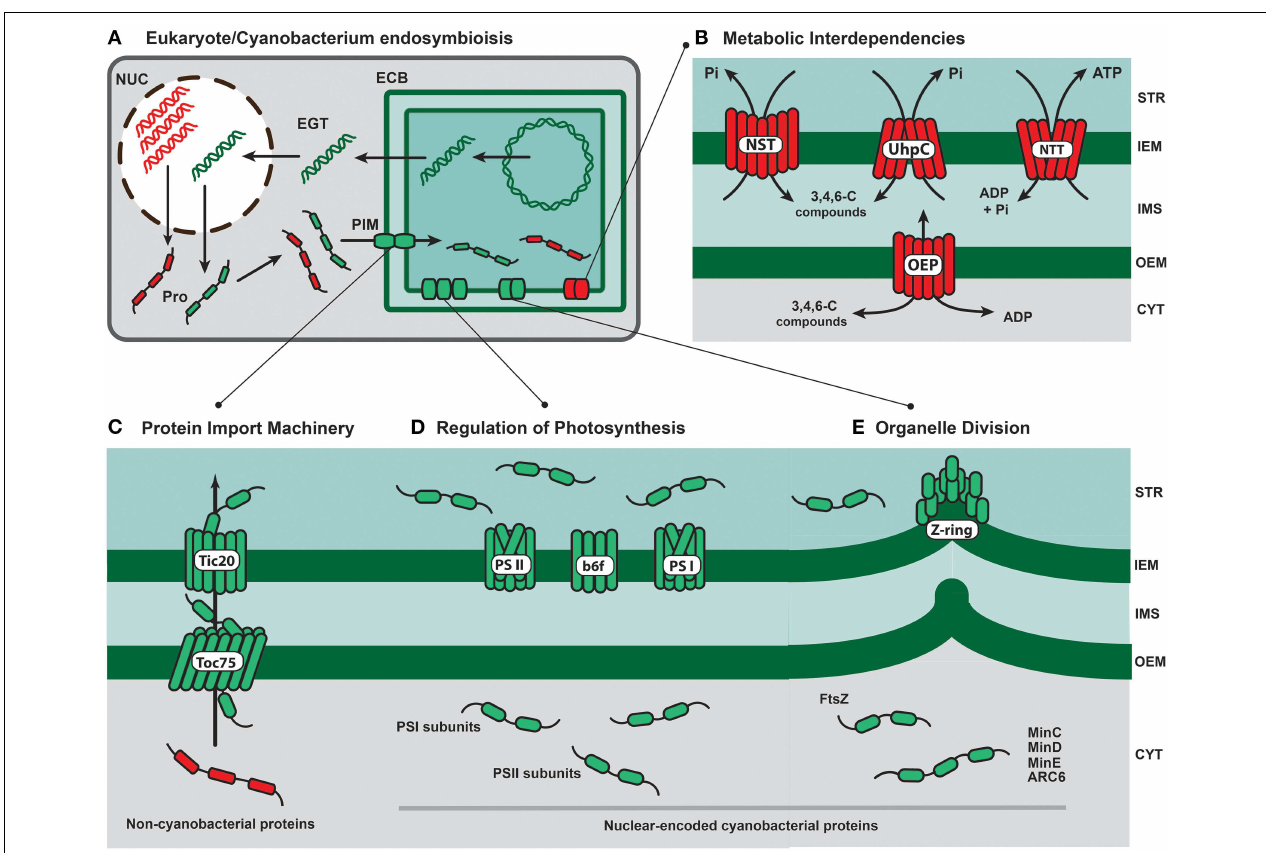
FIGURE 1 | Key subcellular events and proteins involved in the evolution of primary photosynthetic organelles. (A) The genome reduction of the endosymbiotic cyanobacteria (ECB) was triggered by both gene losses via deleterious events and endosymbiotic gene transfer (EGT) into the host nucleus (NUC). Successfully transferred genes (green double strands) should have been expressed and translated in the host nucleocytoplasm system. Cytoplasm-translated proteins (Pro) of non-cyanobacterial origin (red ribbons) and cyanobacterial provenance (green ribbons) were imported into the cyanobacterial compartment via the ancestral protein import machinery (PIM). (B) The recruitment of cytoplasm-translated membrane transporters of host (e.g., members of the NST family and hexose transporters of the UhpC type) and diverse bacterial (e.g., the Chlamydiae-like ATP/ADP nucleotide translocator; NTT) sources was essential for the establishment of steady metabolite (e.g., 3-, 4-, or 6-carbon compounds; ATP) fluxes and further evolution of metabolic interdependencies. OEP represents diverse host-derived pore proteins (e.g., OEP24, OEP16 and OEP21) that facilitate the transport of a broad range of metabolites across the outer envelope membrane. (C) The evolution of the core plastid protein import system relied on the activity of the cyanobacterial proteins Toc75 and Tic20. These two pore-forming proteins were present originally in the plastid ancestor genome but the encoding genes were likely transferred early during endosymbiosis to the host genome (Tic20 are still plastid-encoded in some algal lineages). The ancestral organelle import system was able to translocate both cyanobacterial (green ribbons) and non-cyanobacterial (red ribbons) proteins translated in the host cytoplasm. (D) Other transferred cyanobacterial genes with putative key roles on plastid evolution were those encoding subunits of the Photosytems I ( psa E, psa I, psa K) and II ( psb O, psb P, and psb U) with important roles for the photosynthetic activity under stress conditions. The cytochrome b 6 f complex (b6f) is indicated. (E) Initial host control over the endosymbiont division likely relied on transferred cyanobacterial genes encoding cytokinesis-associated proteins, such as FtsZ, which is a tubulin-like protein fundamental to assemble the contractile Z-ring. The protein FtsZ is nuclear-encoded in most eukaryotes bearing plastids. Other cyanobacterial-derived genes frequently present in nuclear genomes encode the key plastid-division proteins ARC6 MinC, MinD, and MinE. Key code: STR (plastid stroma); IEM (inner envelope membrane); IMS (intermembrane space); OEM (outer envelope membrane); CYT (host cytoplasm). Red and green rounded rectangles represent non-cyanobacterial and cyanobacterial-derived proteins,